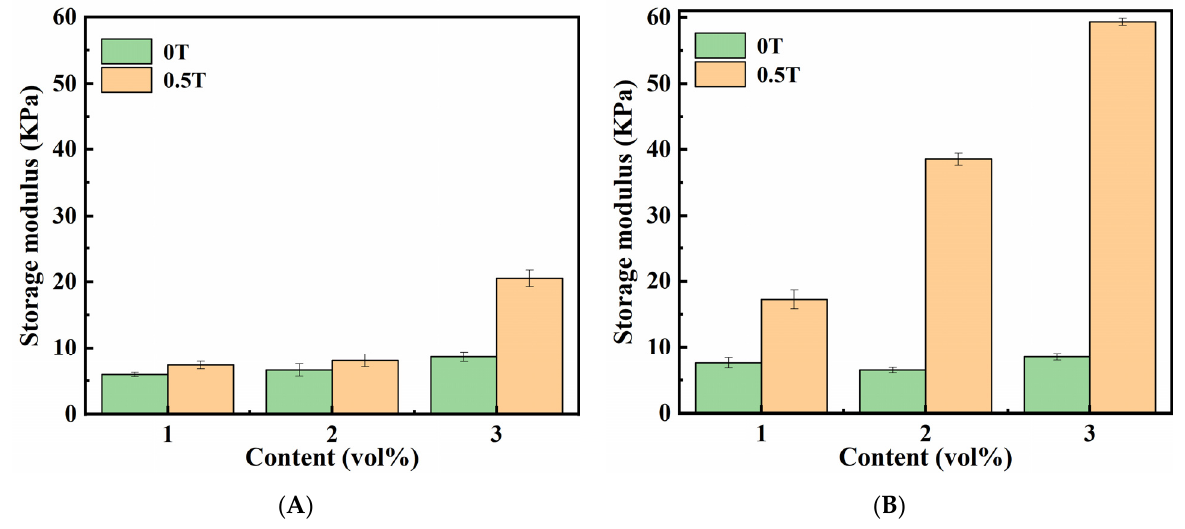
Figure 8. Effects of the contents of CI on the G’ of isotropy ( A ) and anisotropy ( B ) samples within LVE region (F = 10 rad/s, B = 0 T and 0.5 T).